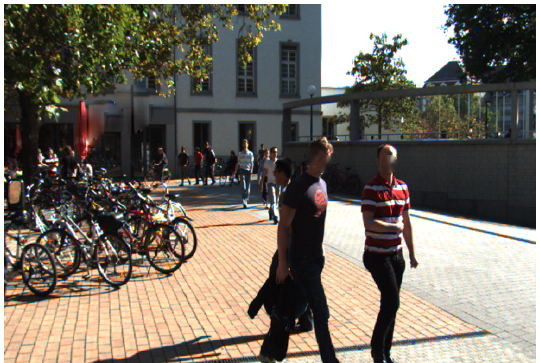
Figure 4. A campus pedestrians tracking.The training sequences number 17 of the Karlsruhe Institute of Technology and Toyota Technological Institute (KITTI) tracking benchmark.